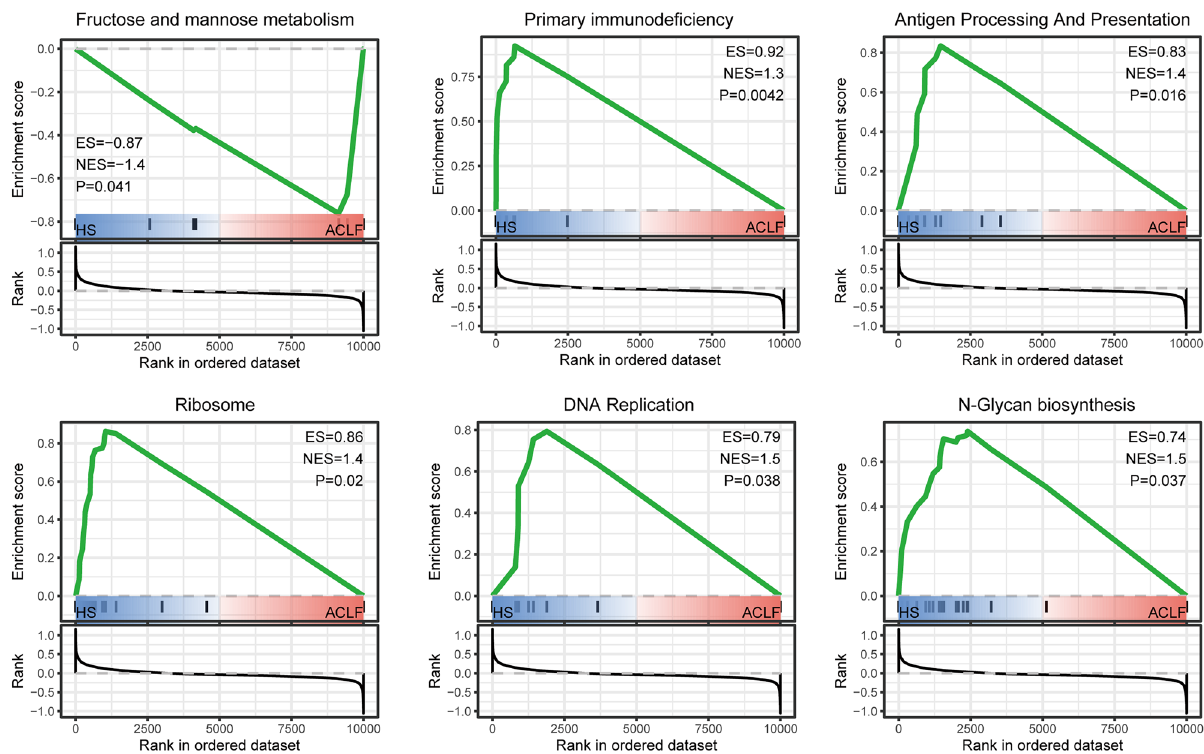
Figure 3. Six significantly enriched gene sets of ACLF patients in GSE142255 through Gene Set Enrichment Analysis